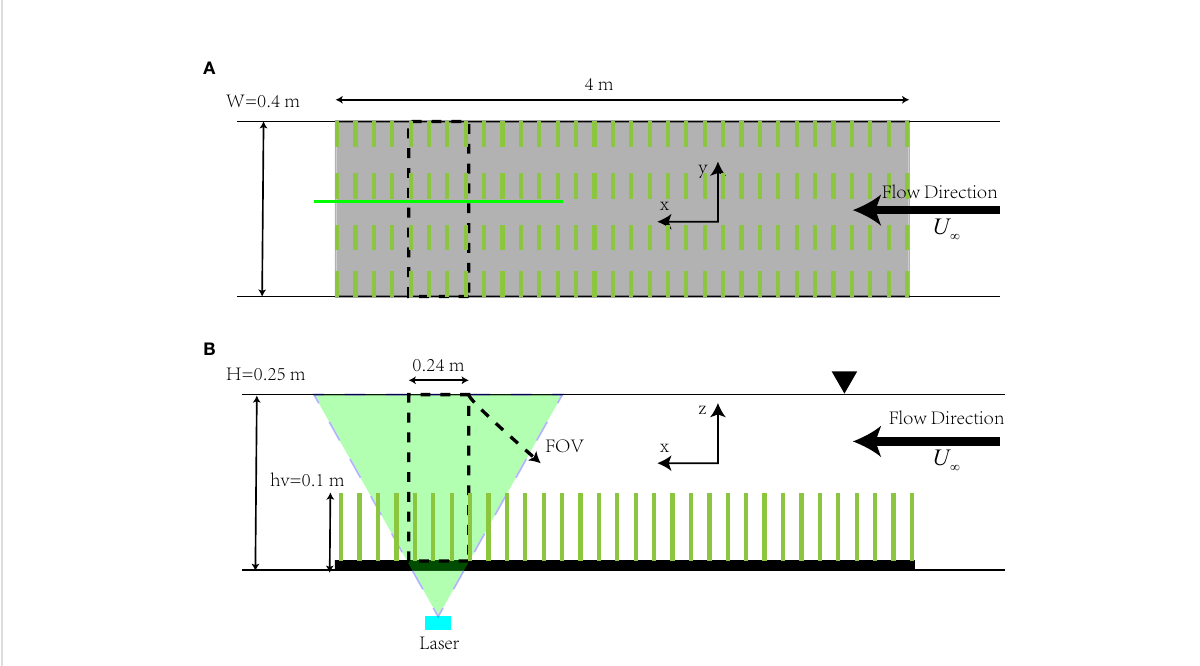
FIGURE 1 Views of the experimental section (not to scale), where the black dashed line in the fi gure is the PIV acquisition area (FOV): (A) top view; (B) side